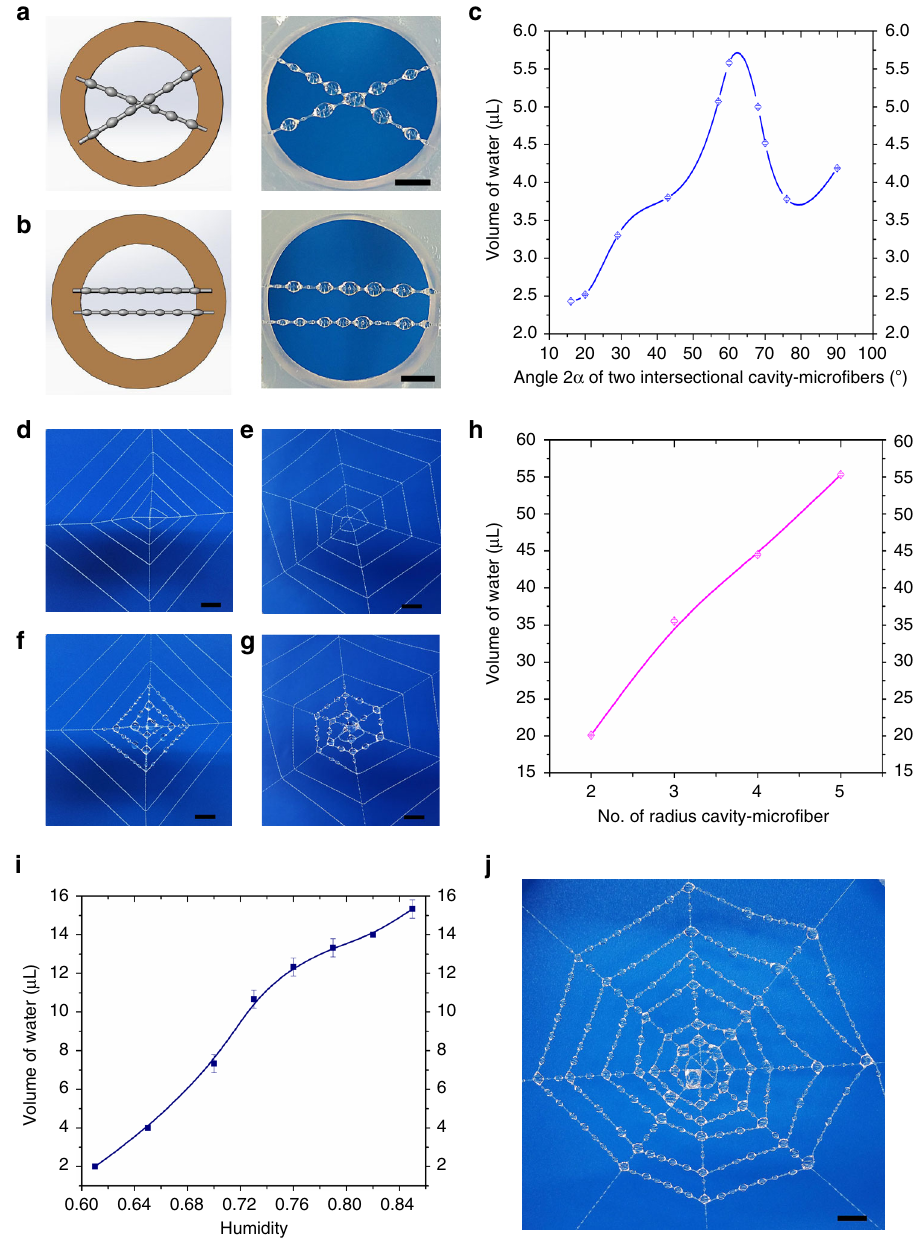
Fig. 5 Water collection of cavity-micro fi ber topological networks. a The schematic diagram and water collection of intersectional structure of cavity-micro fi ber (fog fl ow: 0.408 mL min − 1 ). b The schematic diagram and water collection of parallel structure of cavity-micro fi ber as contrast experiment (fog fl ow: 0.408 mL min − 1 ). c A plot of the water volume collected by the two intersectional cavity-micro fi bers with the angle 2 α against the angle (fog fl ow: 0.408 mL min − 1 ). d Spider-web-like cavity-micro fi ber topological networks with two radius cavity-micro fi bers. e Spider-web-like cavity-micro fi ber topological networks with three radius cavity-micro fi bers. f Water collection of topological networks with two radius cavity-micro fi bers